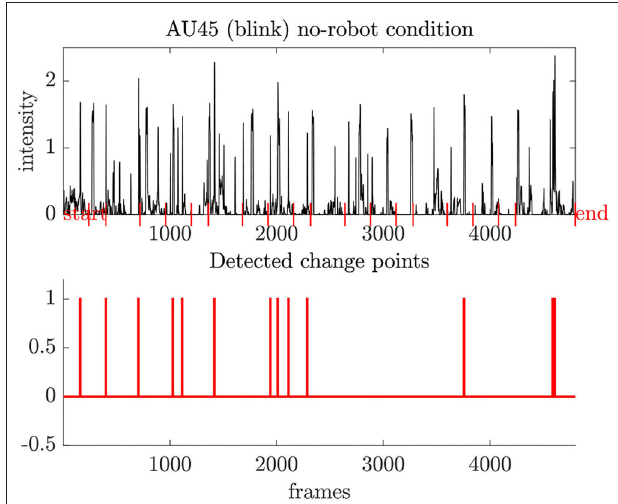
FIGURE 10 | Typical blink pattern (AU45) for participants during the experiment. Our change point detection scheme reveals most activity related to the task onset.